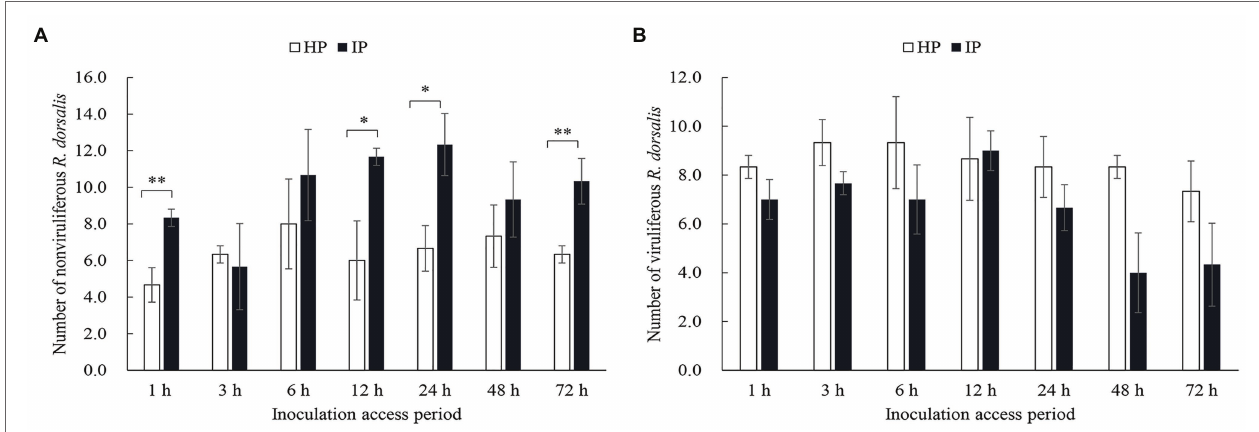
FIGURE 1 | Nonviruliferous Recilia dorsalis preferred to feed on infected rice plants. Selective preference of nonviruliferous (A) or viruliferous (B) R. dorsalis adults to rice gall dwarf virus (RGDV) infected or healthy rice plants. The histogram bars show the number of insects feeding on healthy or RGDV-infected rice plants. HP, healthy plant; IP, infected plant. Significant differences in gene expression are denoted as * ( p , 0.05) or ** ( p , 0.01); multiple t